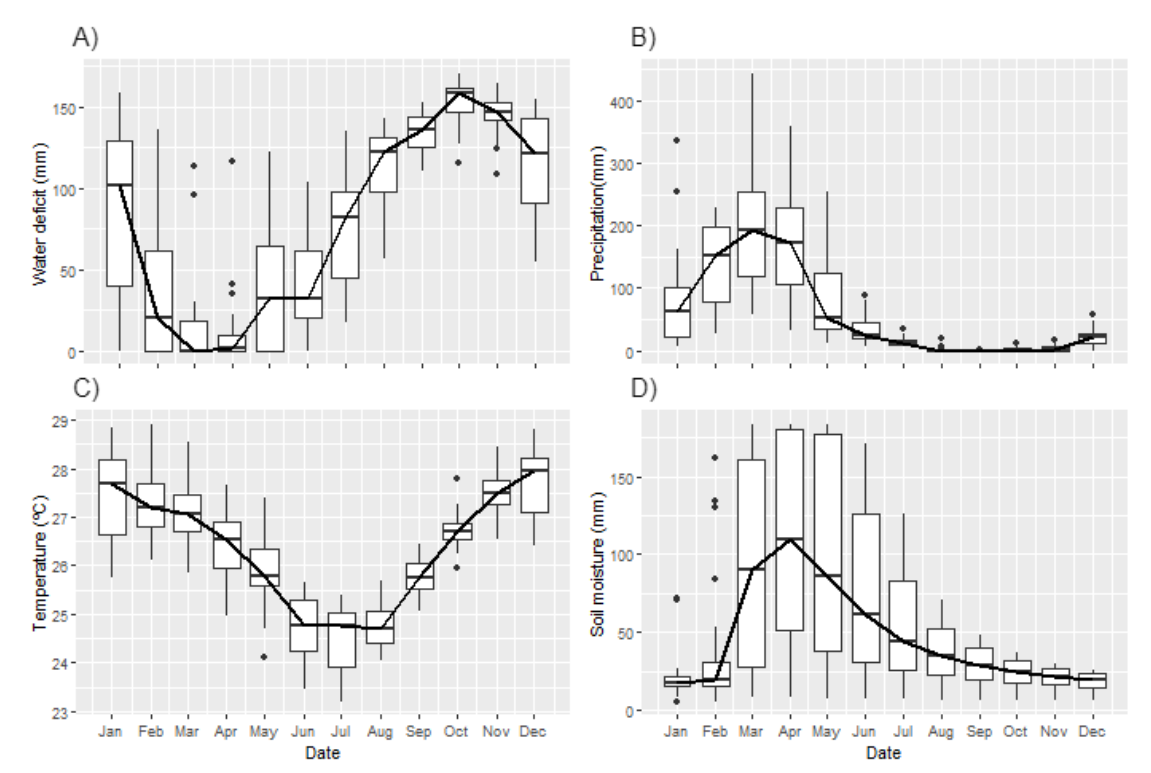
Figure 5. Environment drivers for SD in ( A ) Water Deficit, ( B ) Precipitation, ( C ) Air Temperature, and ( D ) Soil moisture.